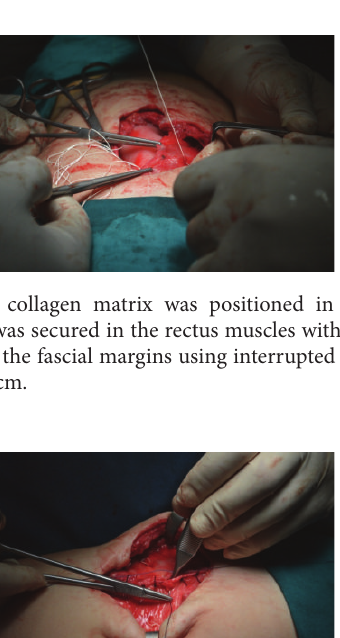
Figure 2: The acellular porcine dermal mesh was cut in a larger size (12cm × 8 cm) than the ventral hernias’ gap dimensions which were 6 cm × 3 cm.